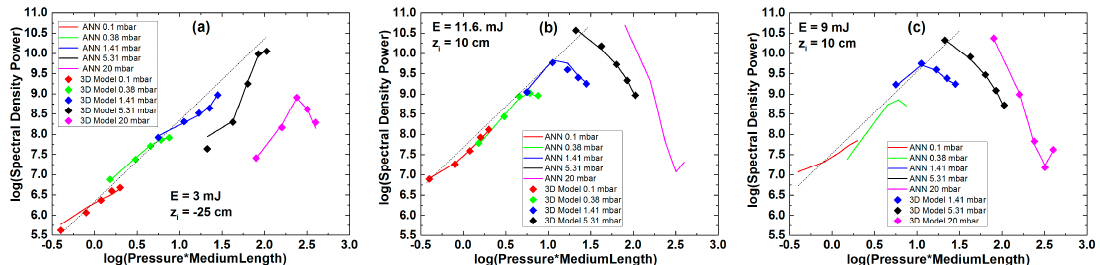
Figure 6. Results of the complete 3D simulation performed with the following values of the parameters: E = 9 mJ; p = 5.31 mbar; z i = − 25 cm. ( a ) Radially integrated power spectrum calculated at every 4 cm of medium length. ( b ) (r,z) map of the driving pulse’s intensity spatial evolution. ( c ) (r,z) map of how the H25 builds up during propagation. Other parameters are specified in the main text at the beginning of Section 3.